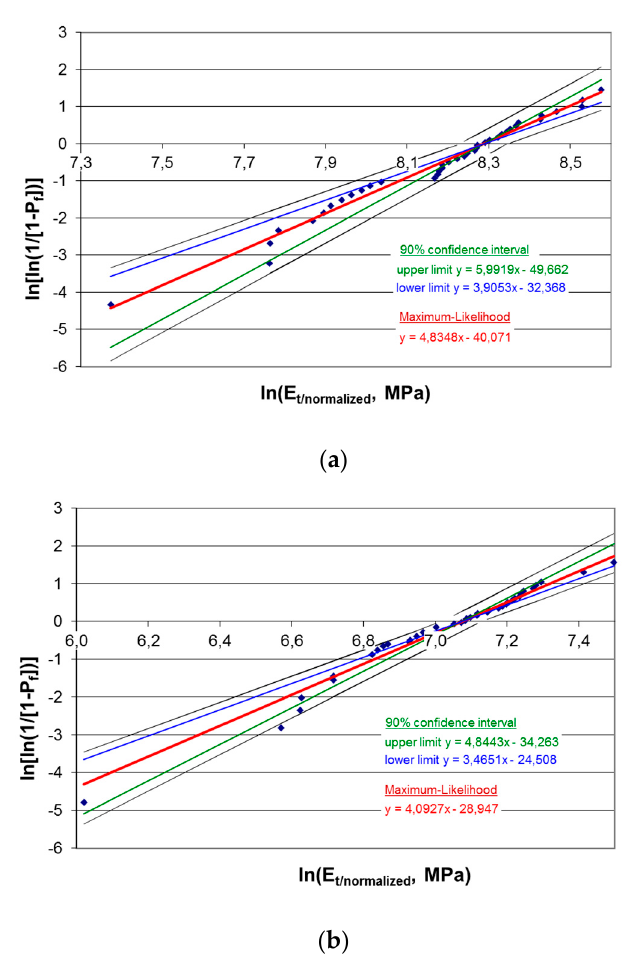
Figure 17. Compression test results—Weibull evaluation of tangent modulus for AlSi7 foam with ( a ) and without TiB 2 grain refiner ( b ), as-received TiH 2 as foaming agent.